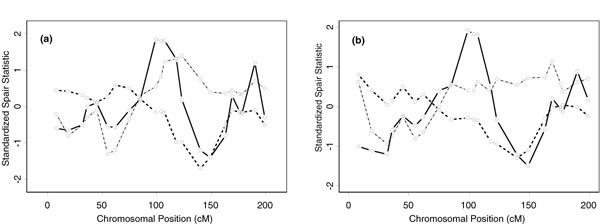
S-pairs standardized statistics at marker locus positions on chromosome 7: (a) HDLAA, (b) HDLA. Solid line: very high (>27.6). Semi-dashed line: low (≤10). Dashed line: high (>10).